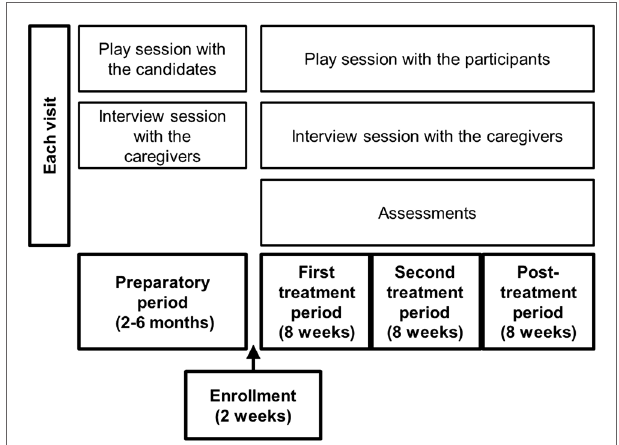
FigUre 1 | schema of the study. Prior to study enrollment, participants, and their caregivers visited Kanazawa University Hospital every 2 weeks during the preparatory period. Each visit consisted of a play session with a participant and an interview session with the caregivers. After the study began, the participants and caregivers visited the hospital eight times every 2 weeks and engaged in the same